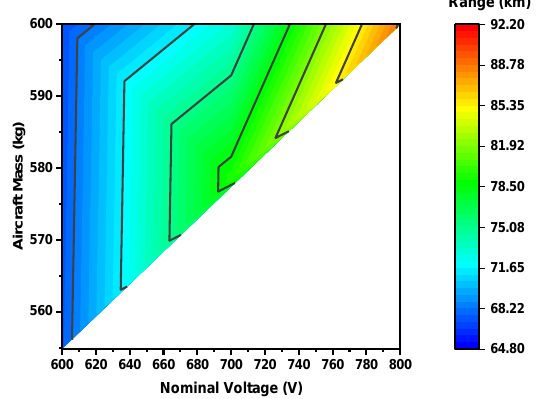
Figure 7. Fully electric mass vs. voltage range comparison.